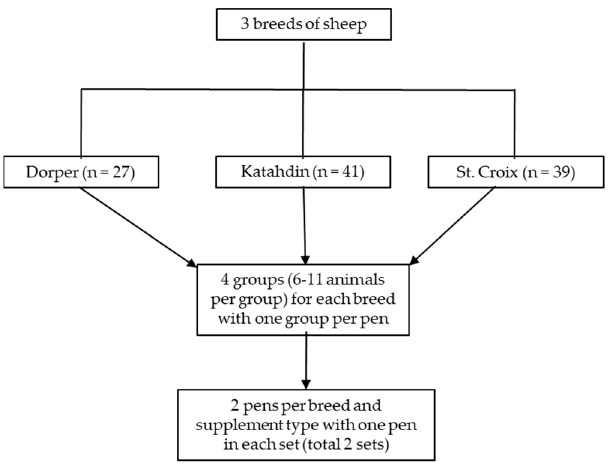
Figure 1. Schematic presentation of the experimental design. Animals were weighed before supplement treatments were first imposed. Body